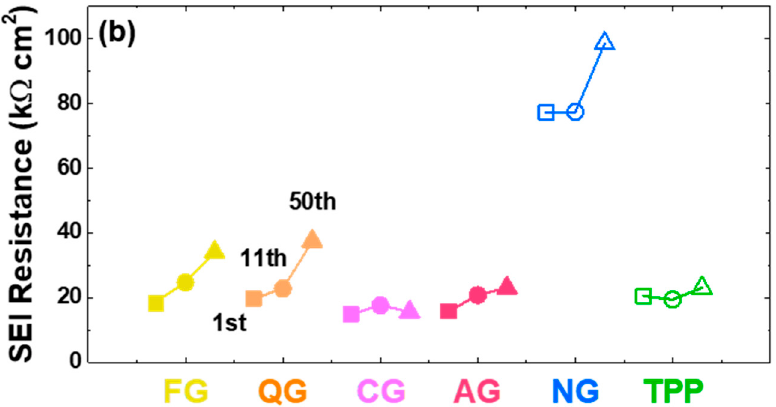
Figure 6. Symmetric-cell electrochemical impedance spectroscopy with various graphite electrodes. ( a ) Impedance spectra of graphite samples at 0.1 V (~50% lithiation). The dashed line predominantly arises from the SEI resistance. ( b ) Changes in the SEI resistance after the 1st, 11th, and 50th cycles of graphite samples.